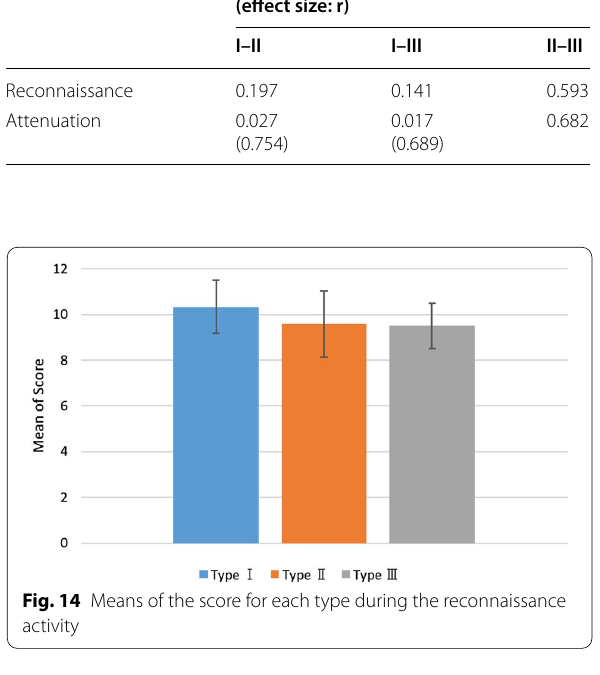
Table 15 p-values based on a comparison for each type p value corrected by Shaffer’s method (effect size: r)